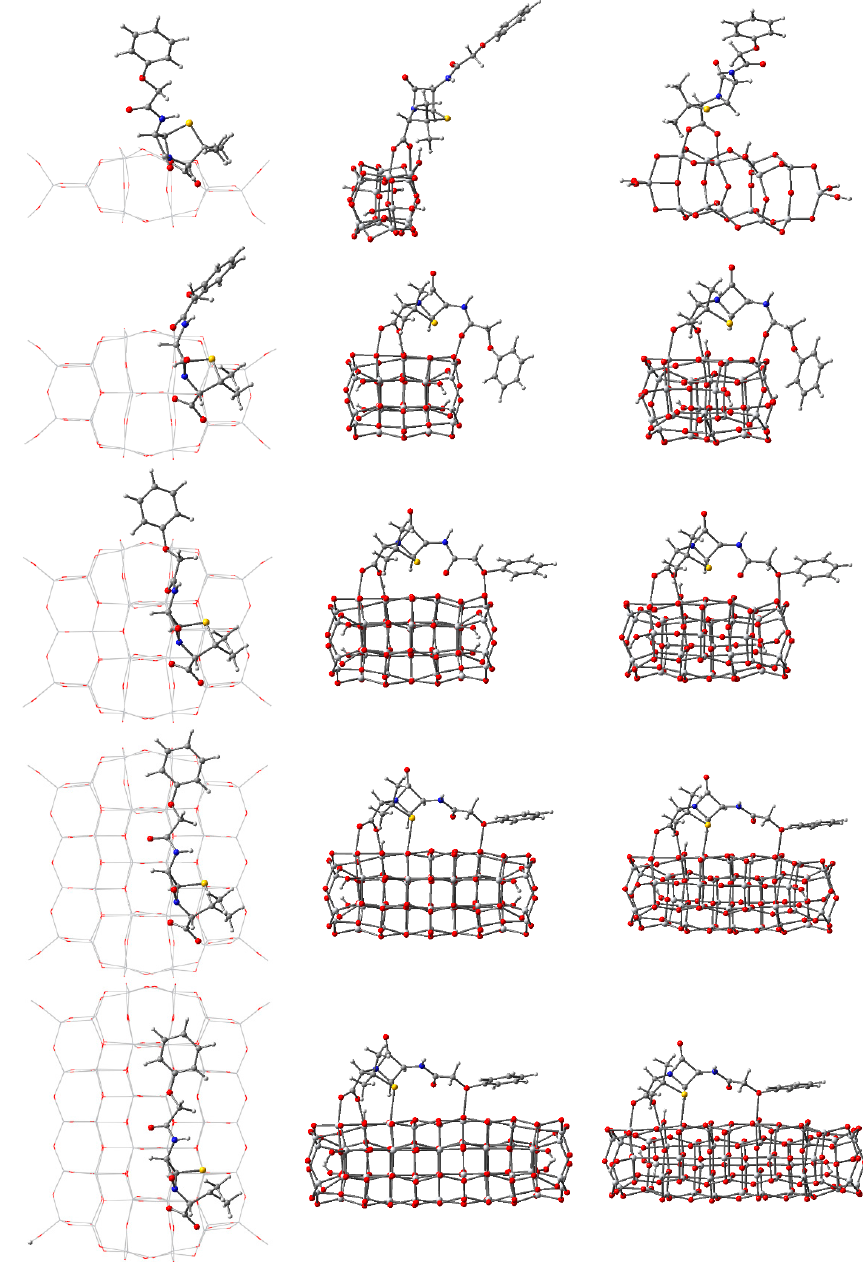
Figure 16. Top view (first column), side view (second column), and perspective view (third column) of the optimized structures of the Penicillin V molecule adsorbed on Ti n O 2 n +2 H 4 clusters, with n = 14, 24, 34, 44, 54, on the first, second, third, fourth, and fifth rows, respectively. Calculations performed by DFT at the B3LYP/3-21G(d) level in vacuum. Atom colors are: C, grey; O, red; N, blue; S, yellow; and H, light grey.